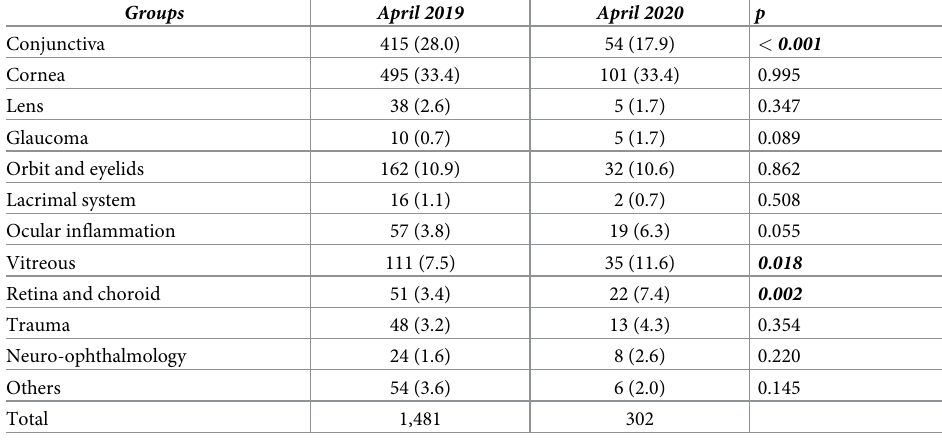
Table 2. Number of diagnoses categorized by group in the representative month of the pandemic outbreak (April 2020) compared with the same month of the year before.